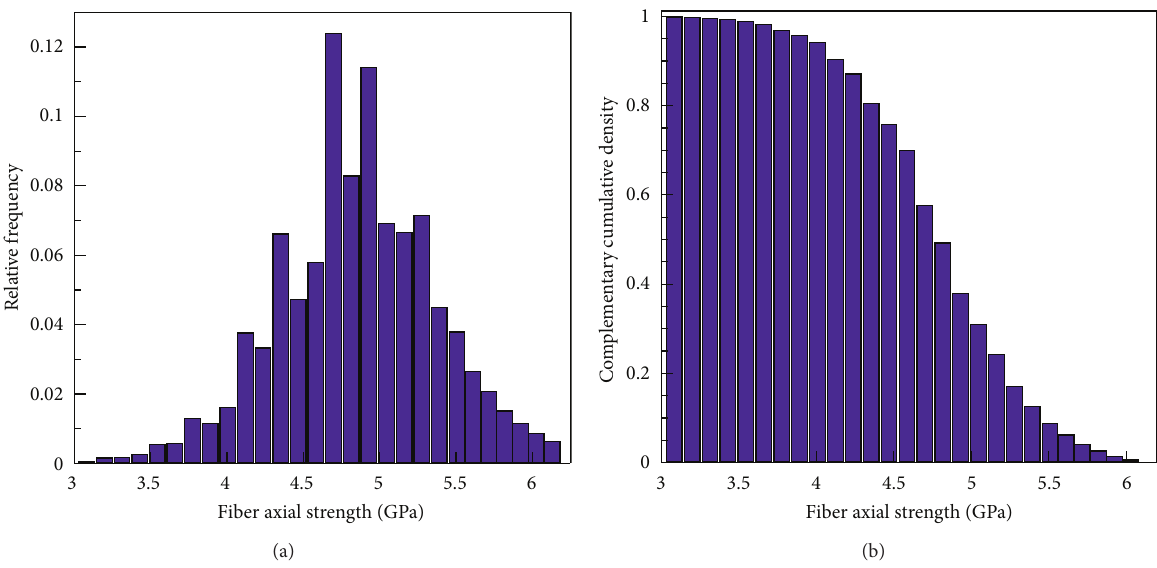
Figure 10: (a) Longitudinal-tensile-strength relative frequency (i.e., probability density function) and (b) the corresponding complementary cumulative density function for PPTA-fibers containing side-group defects after preludial axial compression to a maximum strain of